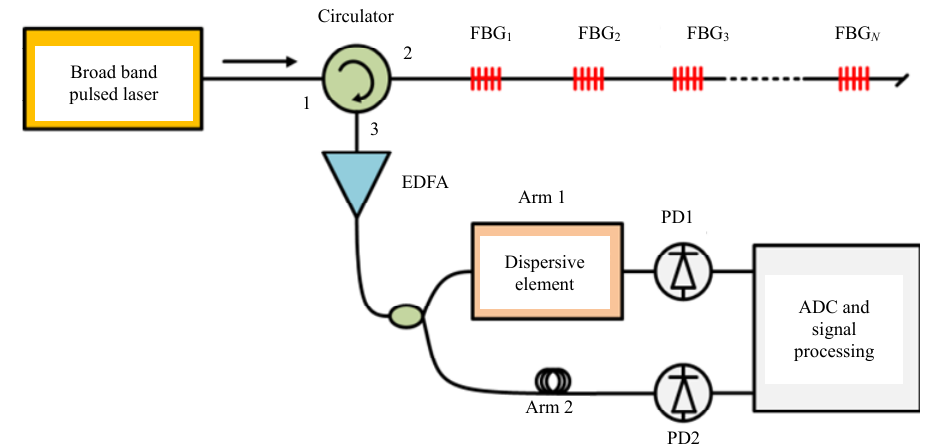
Fig. 4 Interrogation system based on chromatic dispersion [39].